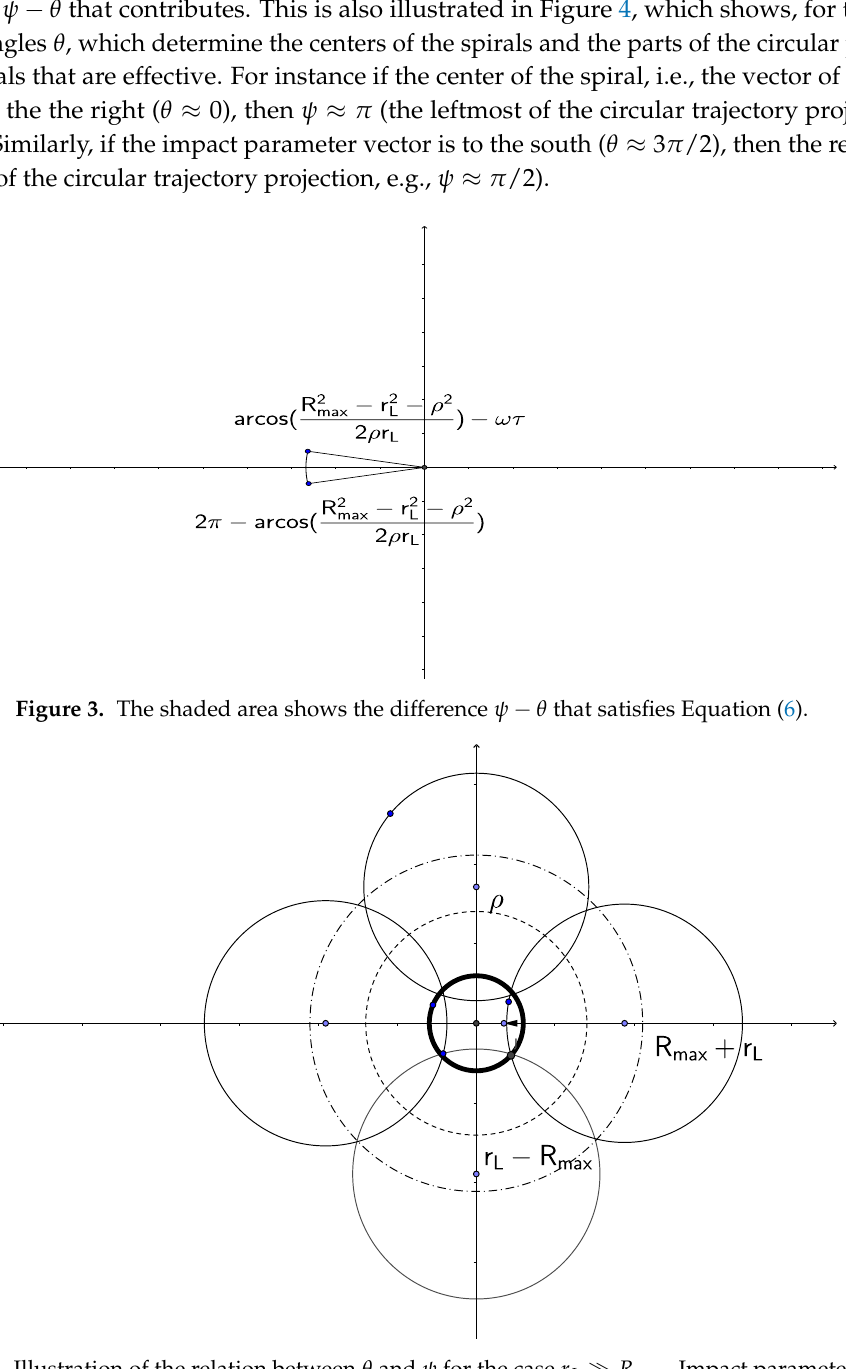
Figure 4. Illustration of the relation between θ and ψ for the case r L (cid:29) R max . Impact parameters ρ lie between the dashed and dash-dotted circles with radii r L − R max and r L + R max . The part of the circular trajectory projections that are within R max (bold circle) of the emitter (i.e., the center) are in the opposite direction of the impact parameter vector, e.g., to the north for the southern circular trajectory projection. R 2 max − ρ 2 − r 2 L ) = π and we get from the θ and In the limit B = 0 (or infinite perturber mass) , arccos ( 2 ρ r L ψ integrations a term ω L τ 2 π